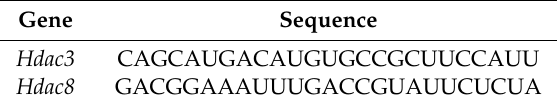
Table 3. Small Interfering RNA